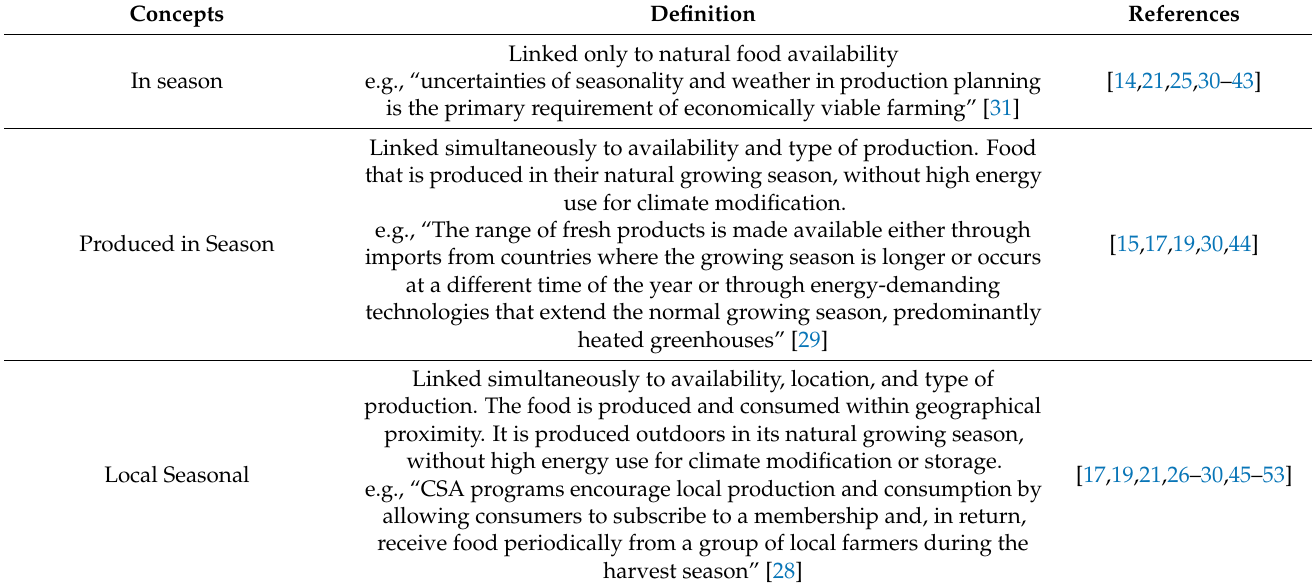
Table 2. Identified concepts and relative definitions used for seasonal